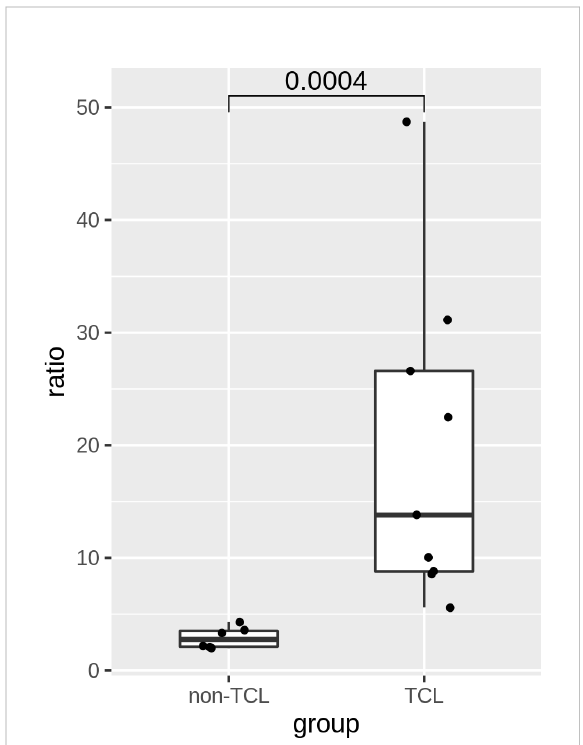
FIGURE 6 Ratios of the J2-2P~J2-3 to the J2-3 sequences in the BM samples of six non-TCL and six TCL patients probed by digital PCR. A p-value of Wilcoxon rank test is